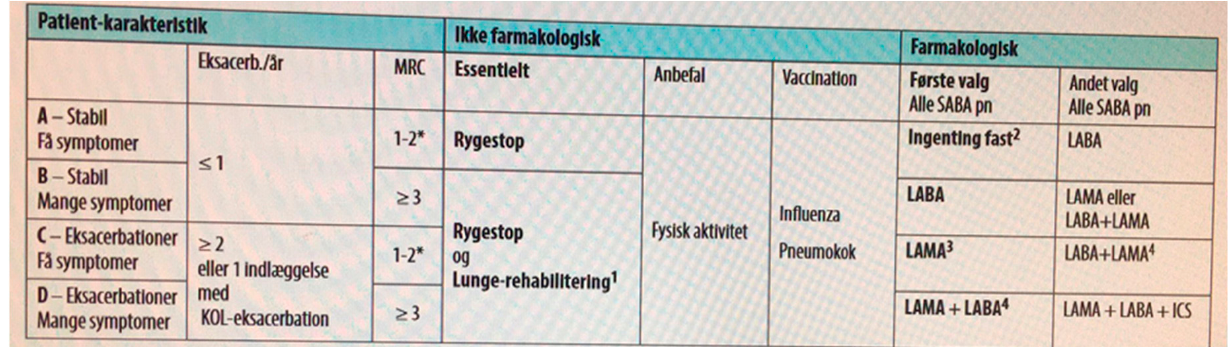
Figure 3. App user interface, measurements.